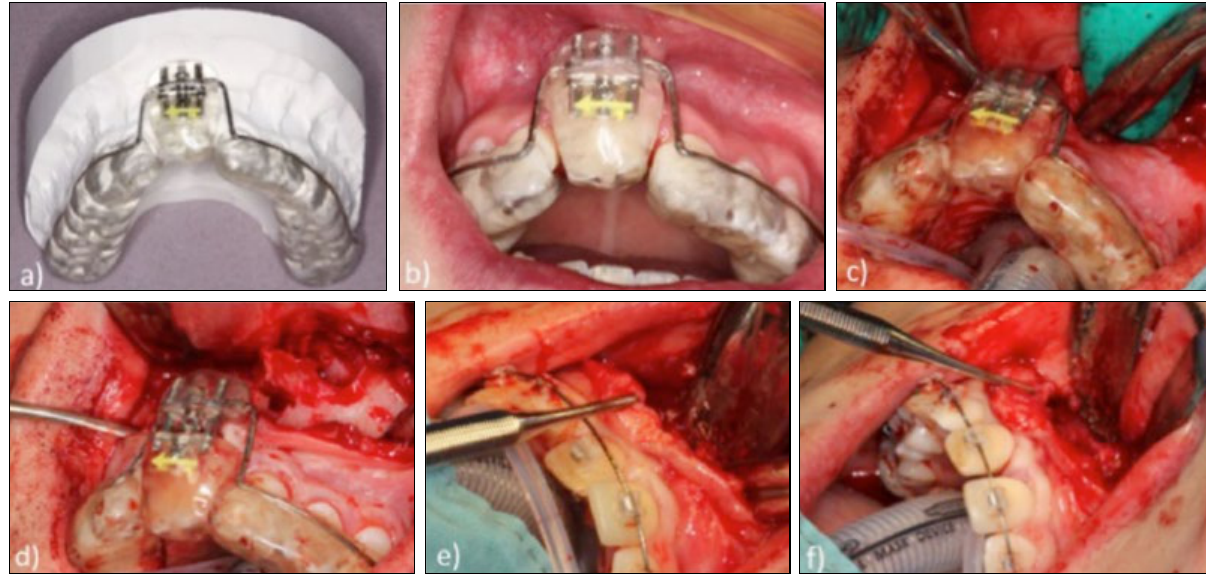
Figure 5. (a) distraction device; (b) distraction device bonded into place; (c) osteotomy of 11; (d) appliance activated during surgery to ensure osteotomised segment movement; (e) second osteotomy to move 11 labially; (f) final position of 11 connected to